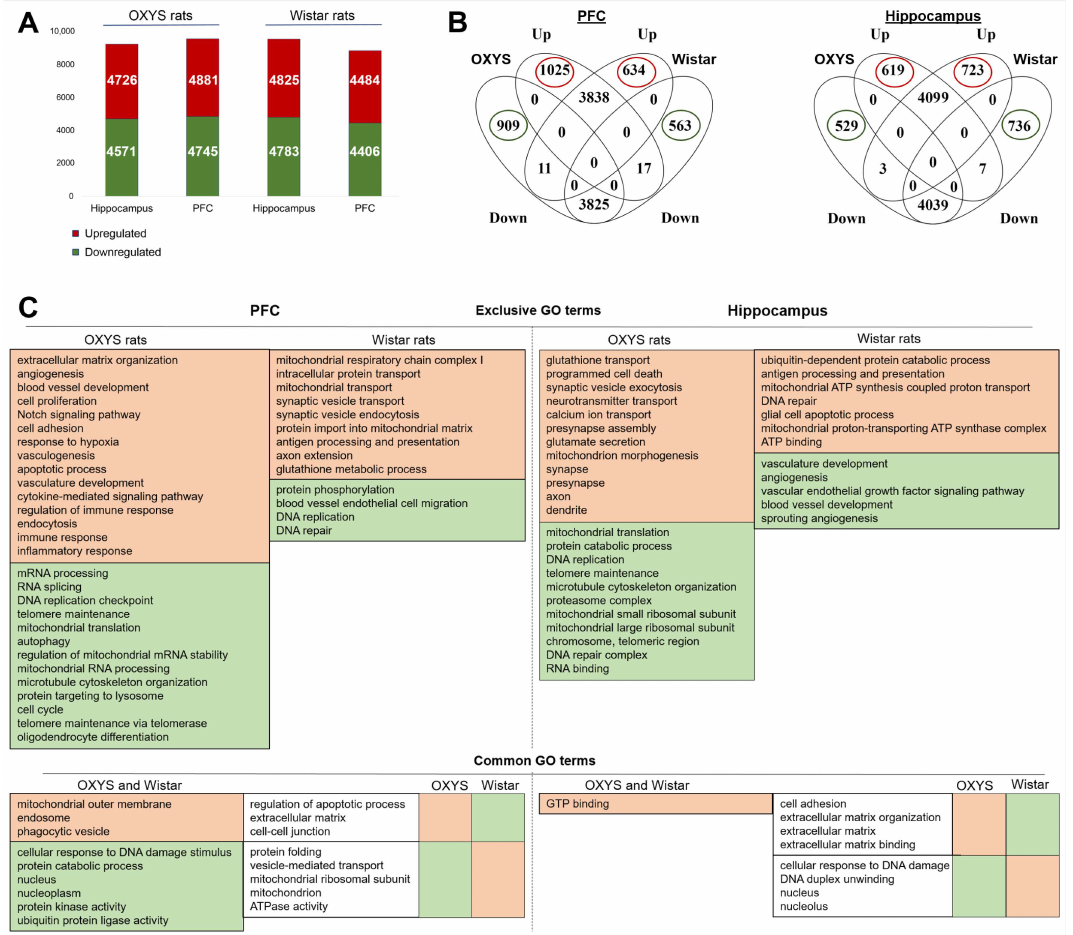
Figure 6. Differential expression of genes: the effect of age. ( A ) The numbers of genes that significantly changed expression in the PFC and hippocampus between ages P3 and P10 in OXYS and Wistar rats. The numbers of DEGs are red if upregulated and green if downregulated. ( B ) The numbers of DEGs either matching or exclusive for OXYS and Wistar rats (in the PFC and hippocampus). ( C ) The most significantly enriched GO terms that are exclusive, common, or common but with opposite directions of changes between OXYS and Wistar rats in the PFC and hippocampus, according to DAVID. The GO terms are red if upregulated and green if